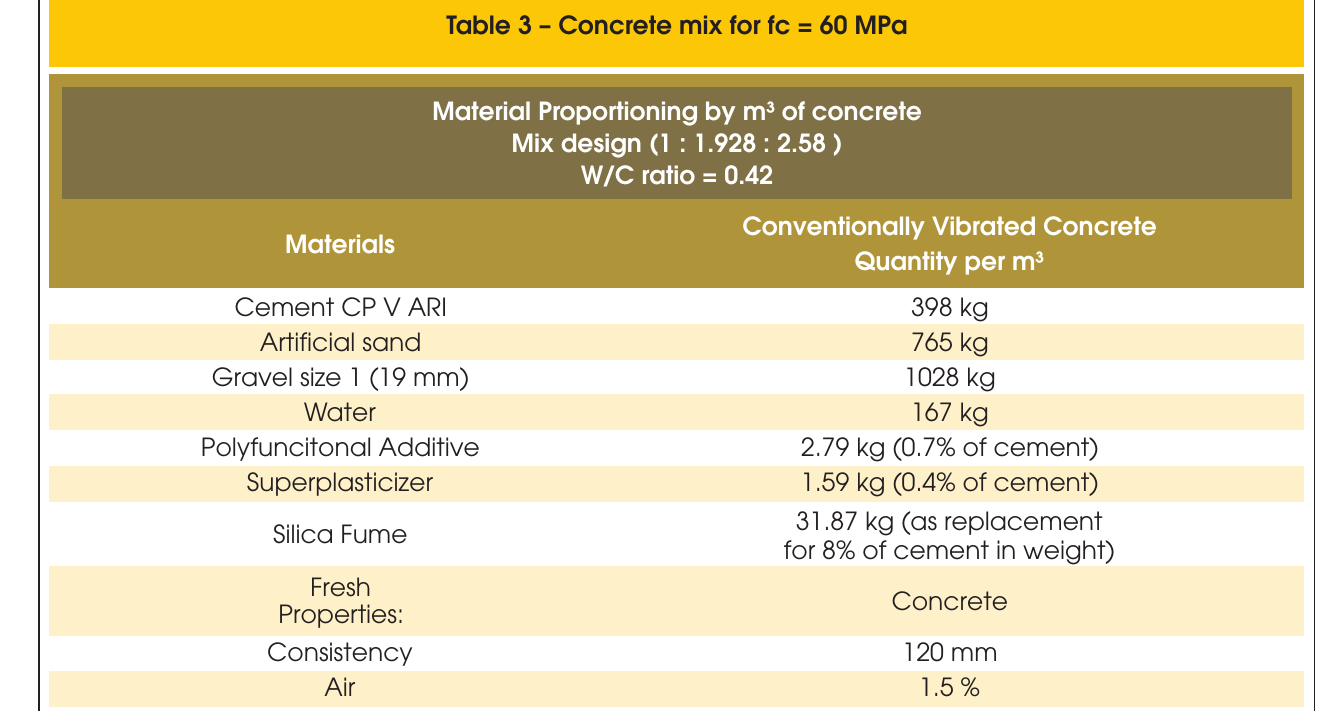
Table 3 – Concrete mix for fc = 60 MPa Material Proportioning by m³ of concrete Mix design (1 : 1.928 : 2.58